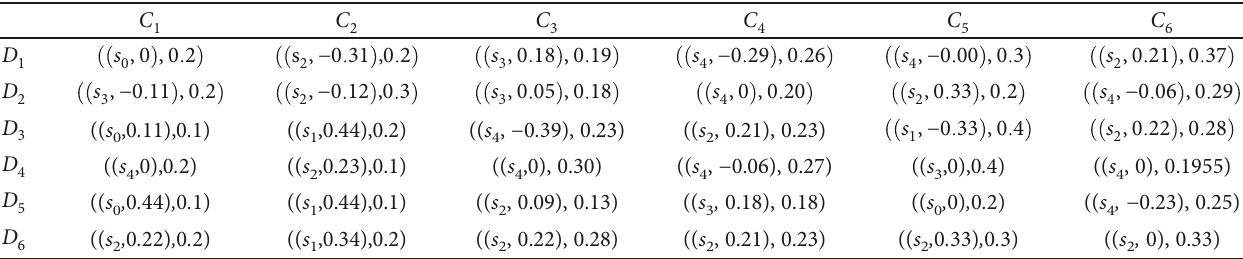
Table 4: The collective opinion for all